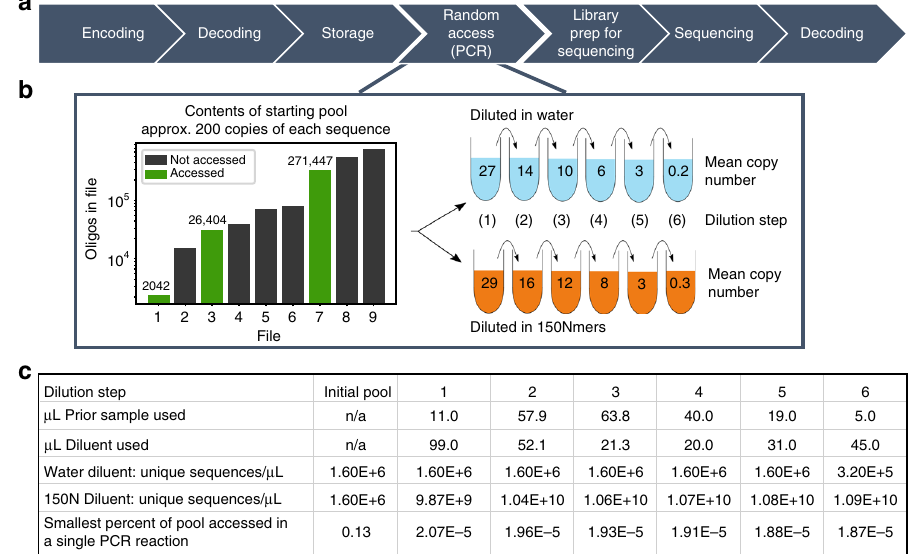
Fig. 1 Experiment overview. a A high-level representation of the DNA data storage pipeline. b (Left) The bar chart depicts contents of the initial, undiluted pool. (Right) The illustration shows the serial nature of subsequent dilutions. Mean copy number refers to the mean number of copies of each fi le's unique sequences as determined by qPCR (Supplementary Note 1). One serial dilution used water as the diluent in each step; the other used a solution of 150 Nmers to dilute the pool to much greater complexity. c Details of how the samples were diluted. Note that the dilution steps were identical regardless of diluent. The smallest percent of pool accessed is calculated by dividing the size of the smallest fi le by the number of unique sequences in the 1 μ L of solution used for PCR random access. This percentage refers to the 150 Nmer diluent pool since the small fi le in the water diluent pool is a constant 0.13%.